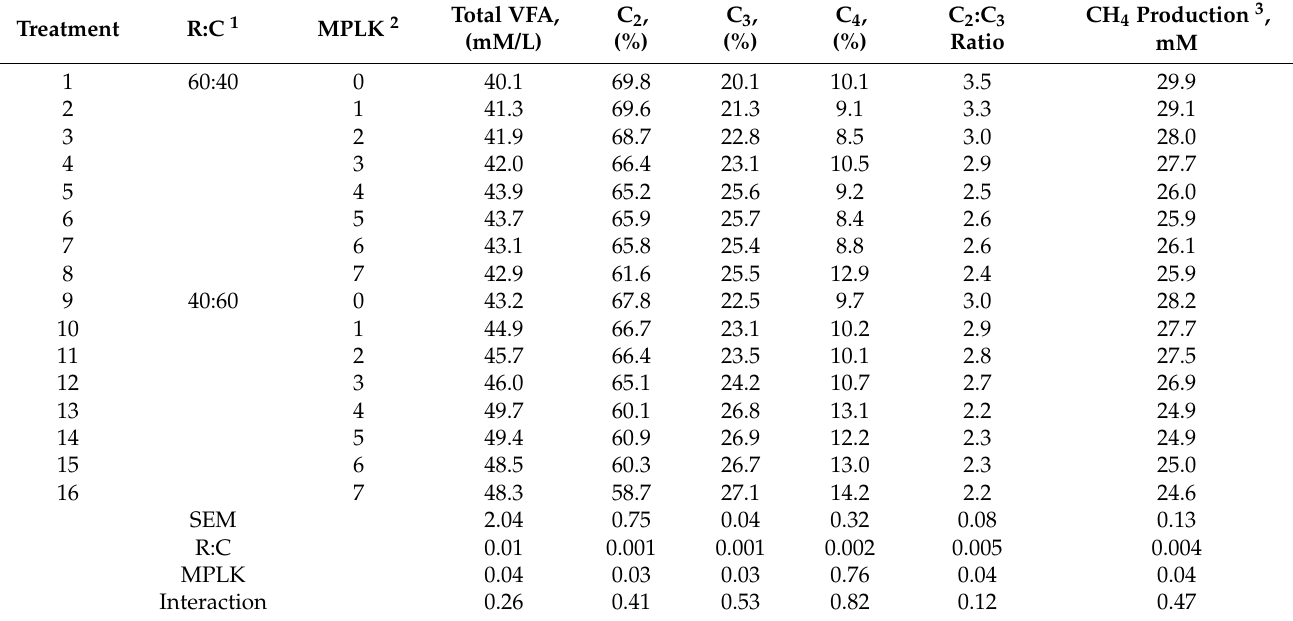
Table 4. The effect of roughage-to-concentrate (R:C) ratio with Mitragyna speciosa Korth leaves powder (MSLP) supplementation on in vitro total volatile fatty acids (VFA), VFA profiles, and methane (CH 4 )